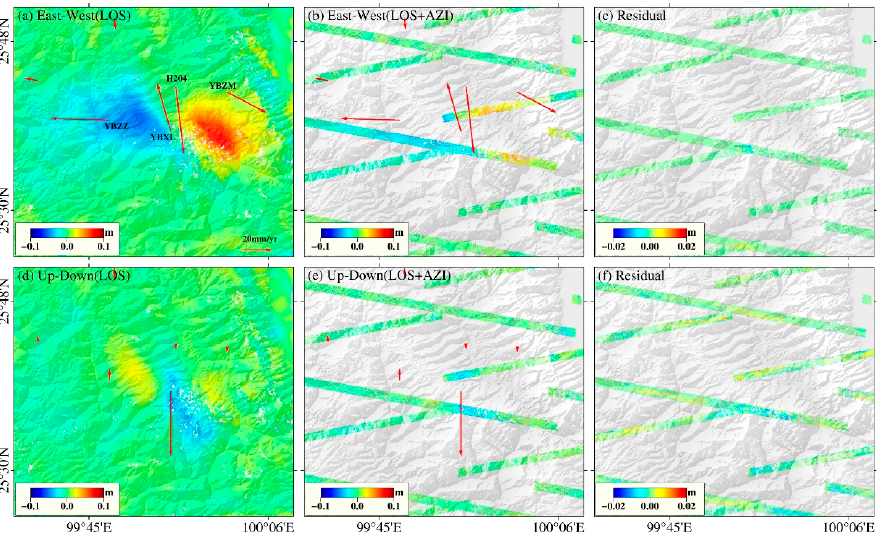
Figure 3. ( a ) East–west (E–W) and ( b ) vertical components of the 2021 Yangbi earthquake calculated from LOS deformation. ( b ) E–W and ( e ) vertical components calculated from LOS and azimuth de- formation. Red arrows denote the GPS horizontal and vertical displacement vectors. ( c ) and ( f ) Dif- ference between ( a ) and ( b ), ( d ) and ( e ), respectively.